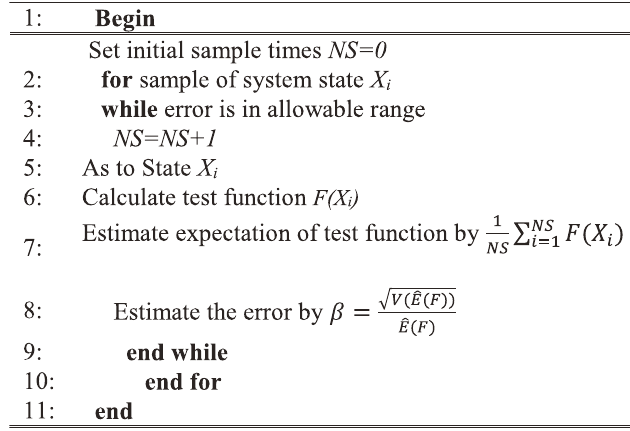
Figure 2: Pseudocode for handling the uncertainties based on the Monte Carlo